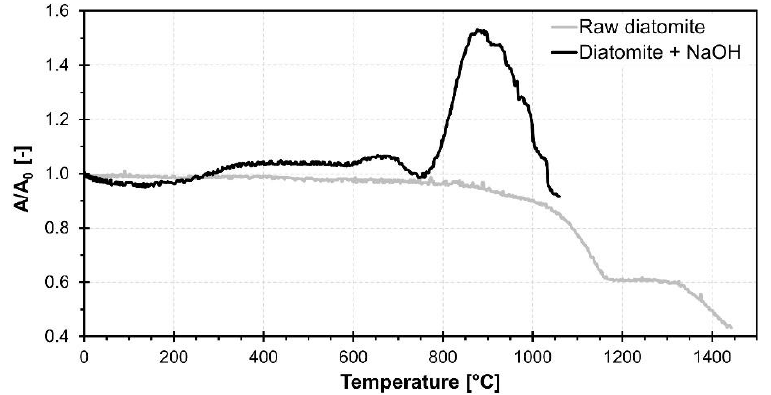
Figure 4. Results of heating microscopy measurement of dried raw diatomite powder and diatomite mixed with NaOH solution.